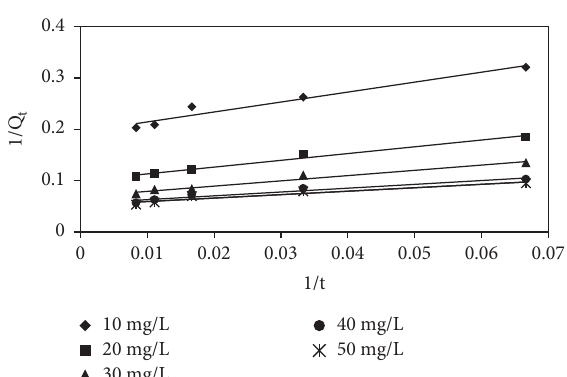
Figure 12: Linearity of the pseudo-second-order model.